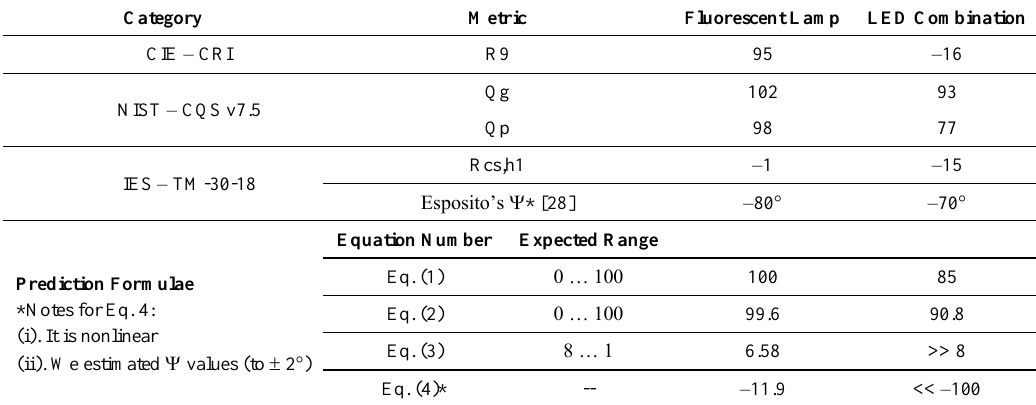
Table 5. Additional results for the Fluorescent lamp and LED combination used in the case